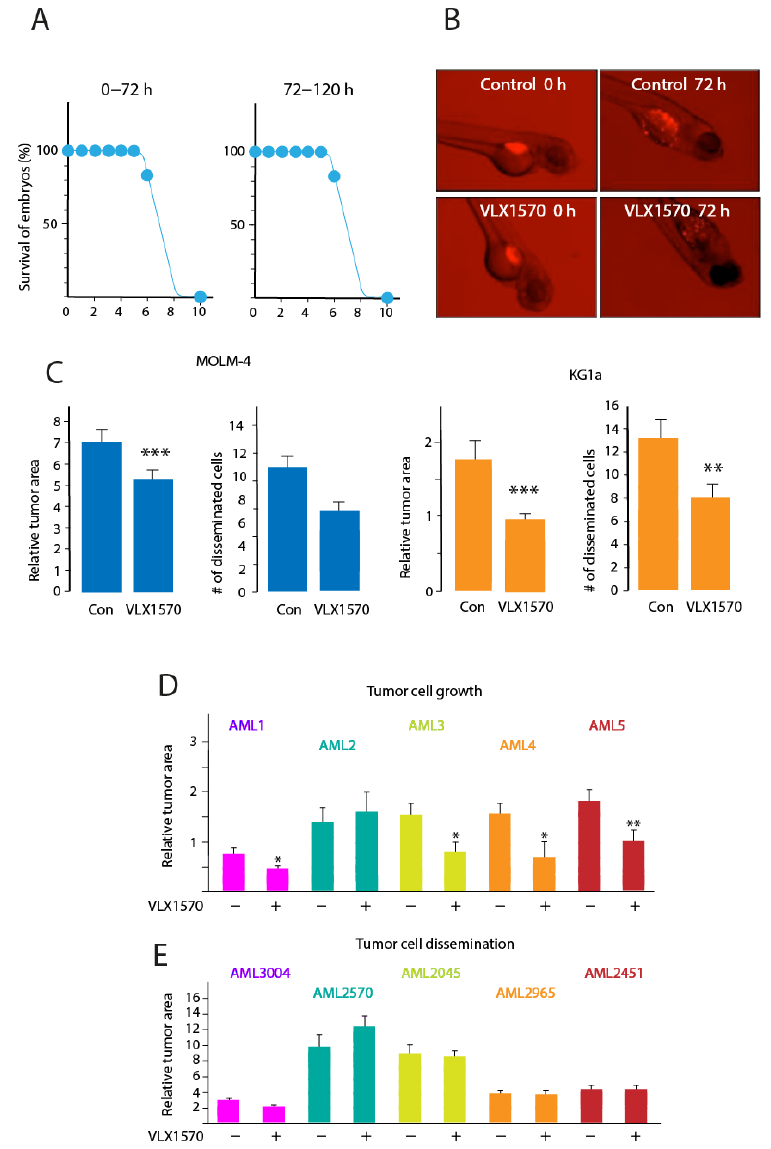
Figure 6. Activity of VLX1570 in the zebrafish embryo model; ( A ) survival of zebrafish embryos exposed to the indicated concentrations of VLX1570 for 0–72 or 72–120 h; ( B ) examples of results obtained using labeled AML cells injected into zebrafish embryos followed by treatment with VLX1570; ( C ) effect of 1µM VLX1570 on the growth and dissemination of injected AML cell lines in zebrafish embryos (student’s t test, ** p ≤ 0.01, *** p ≤ 0.001); and ( D , E ) effect of 1 µM VLX1570 on the growth and dissemination of injected primary AML cells in zebrafish embryos (student’s t test, * p ≤ 0.05, ** p ≤ 0.01). Table 4. Primary AML cells used in the present study.